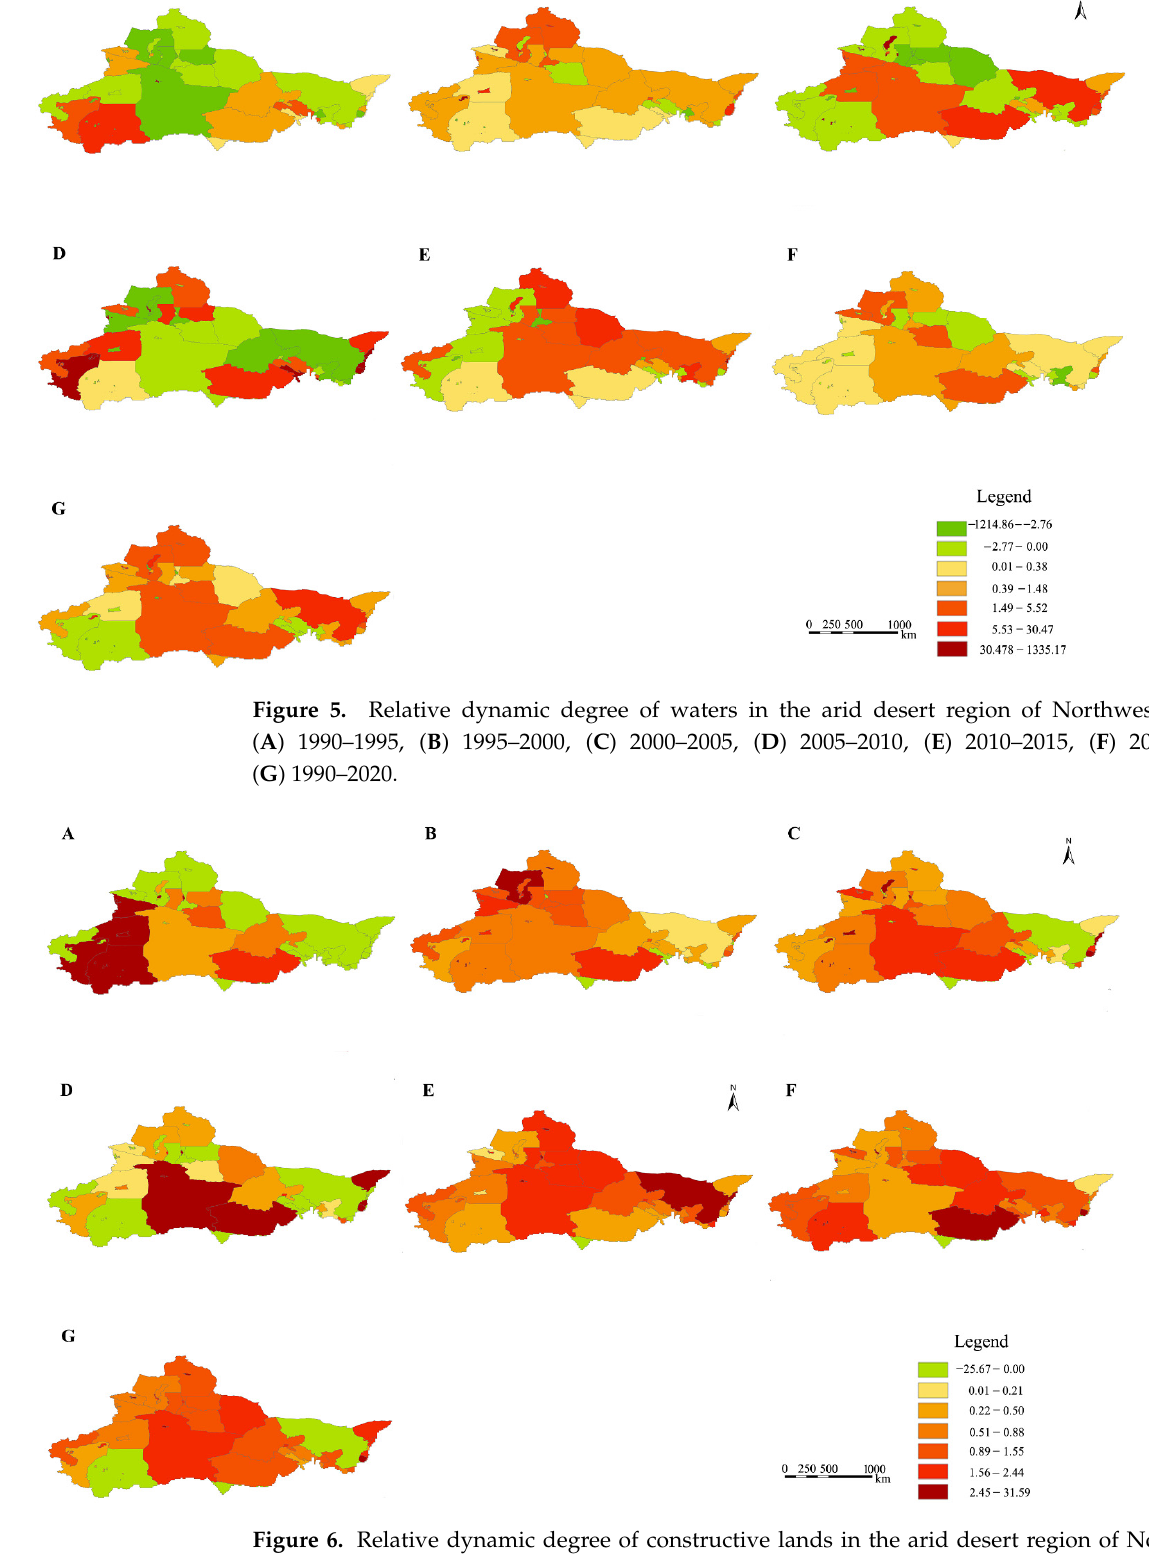
Figure 6. Relative dynamic degree of constructive lands in the arid desert region of Northwest China, ( A ) 1990–1995, ( B ) 1995–2000, ( C ) 2000–2005, ( D ) 2005–2010, ( E ) 2010–2015, ( F ) 2015–2020,